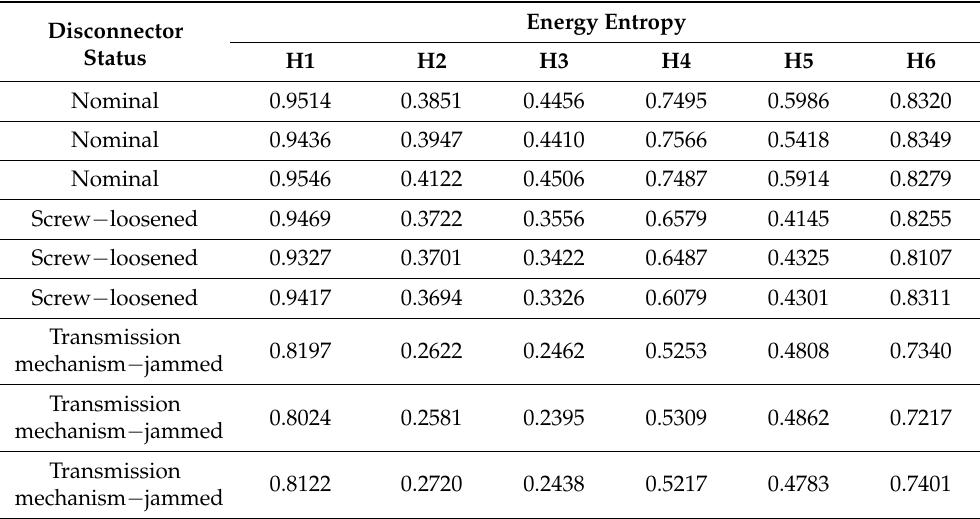
Table 2. Average energy entropy of three groups of random signals of the disconnector in the three operating